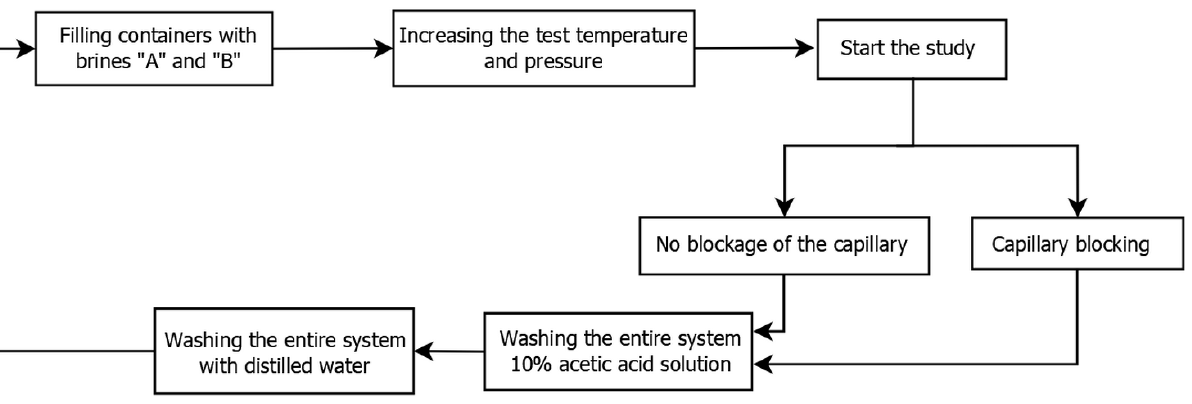
Figure 2. Research Figure 2. Research flowchart.